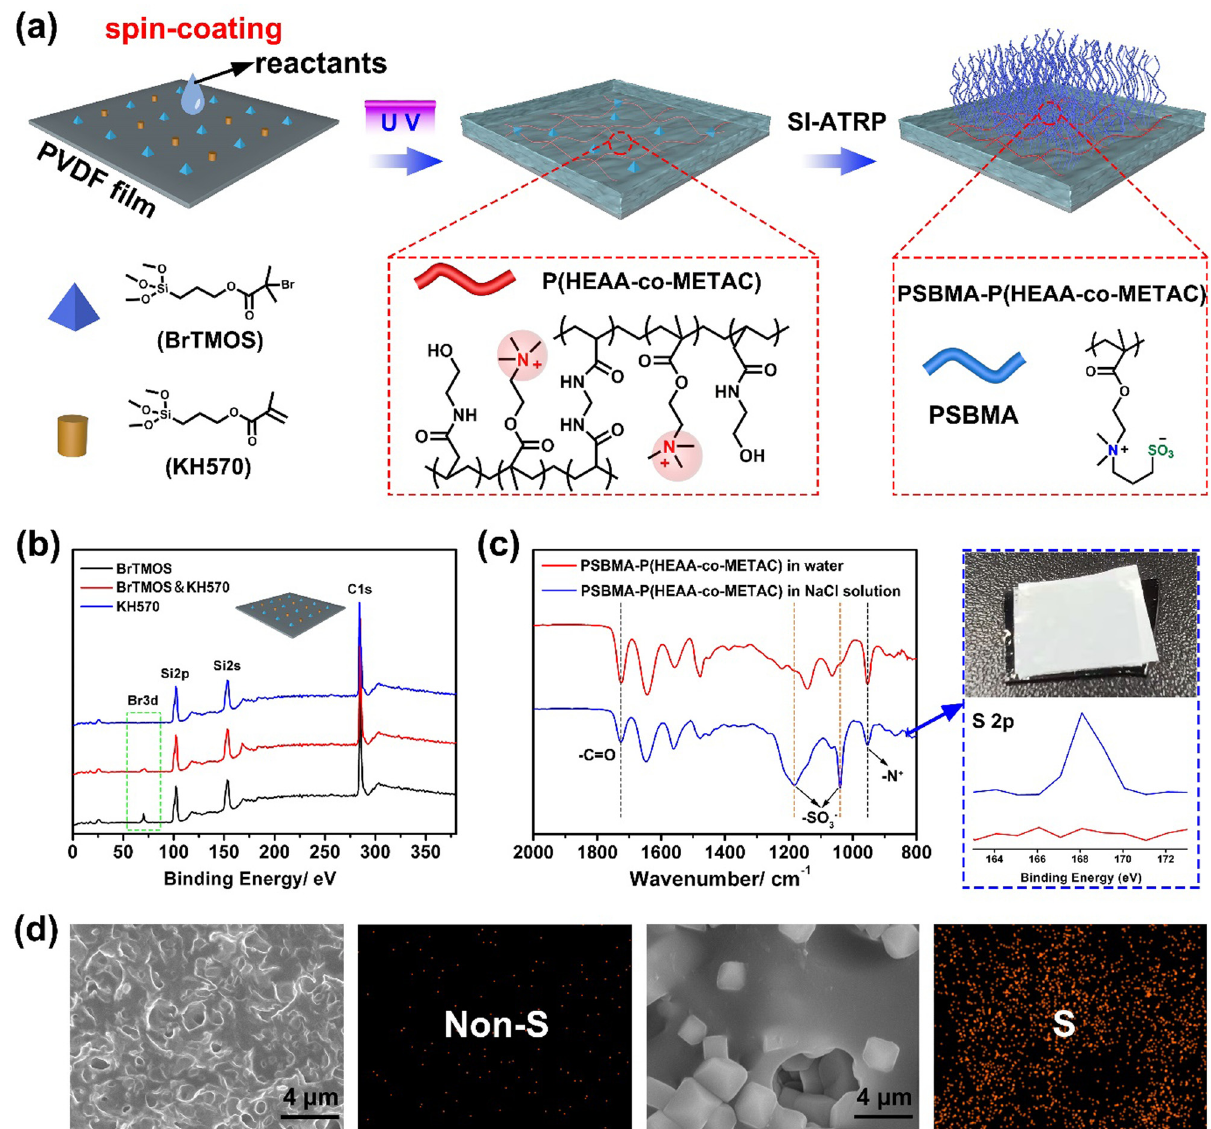
Figure 1: ( a ) Schematic illustration for the fabrication of hybrid PSBMA - P ( HEAA - co - METAC ) coating onto PVDF fi lm with bacterial “ contact killing – releasing ” properties. ( b ) Comparison of XPS spectra for PVDF fi lm modi fi ed with BrTMOS, KH570, and BrTMOS – KH570. ( c ) FT - IR